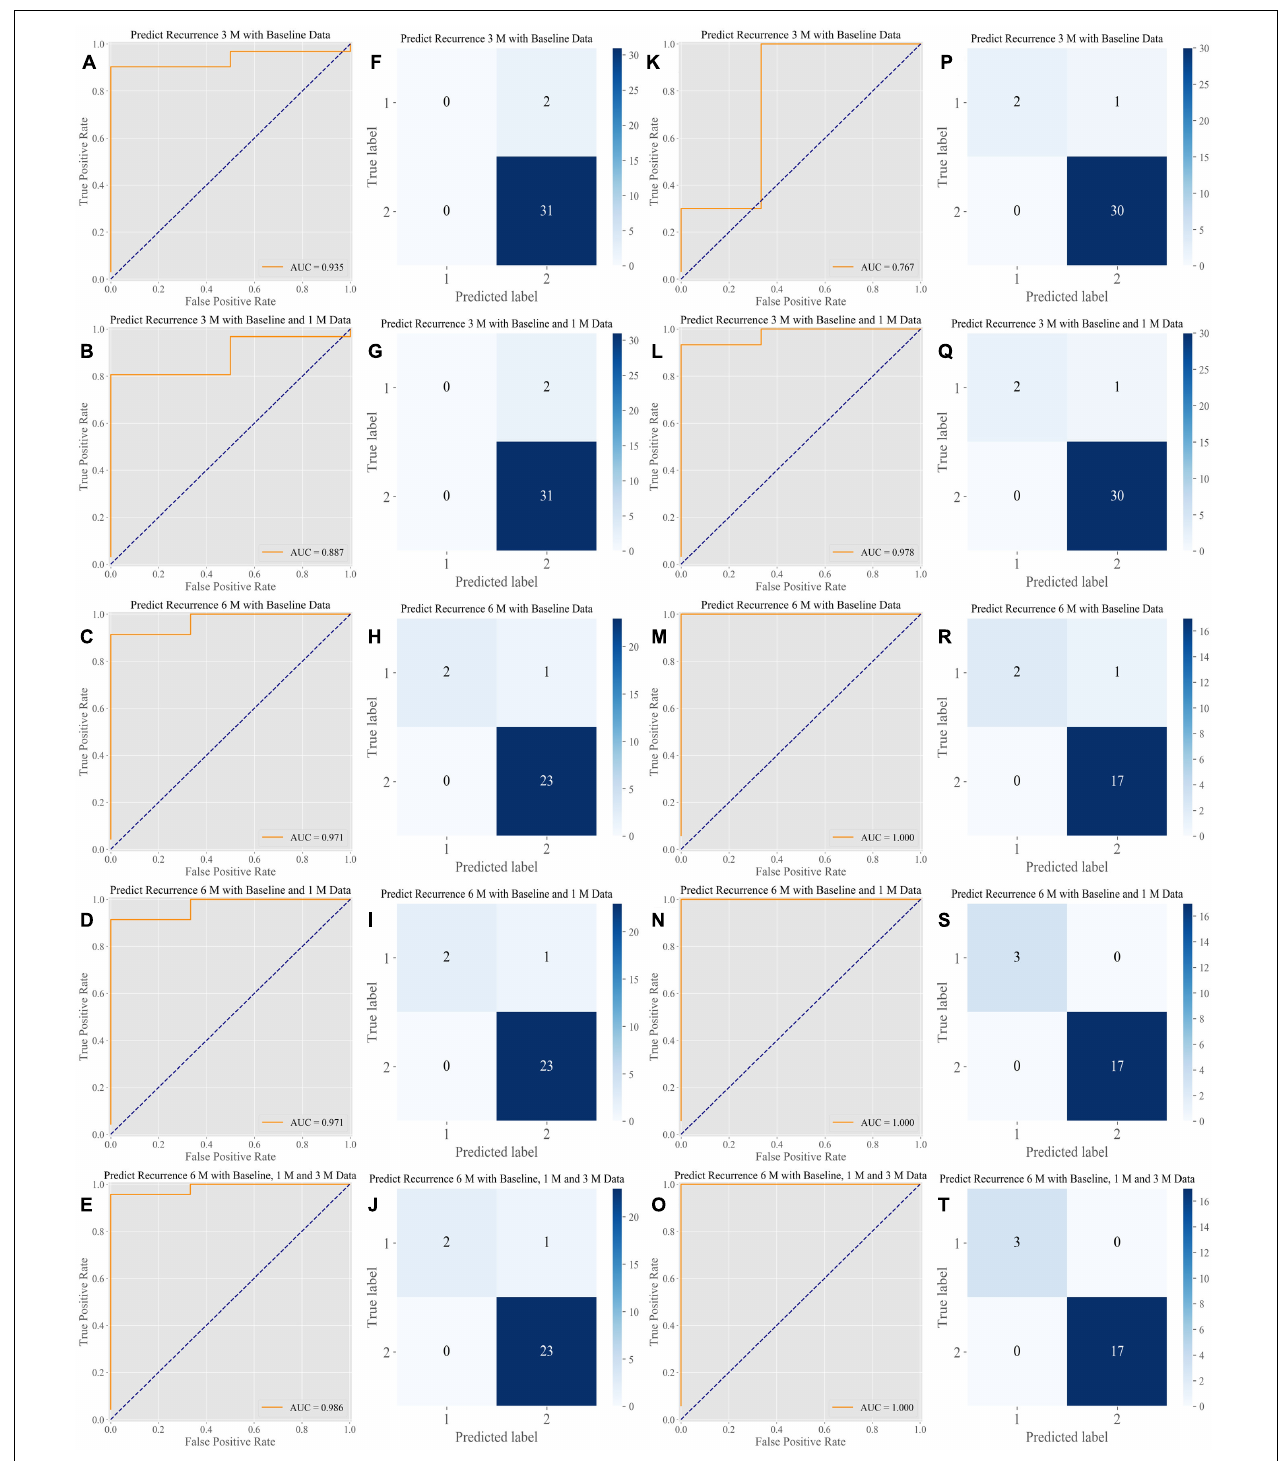
FIGURE 3 | Performance of the algorithms in the internal test dataset and the External Test Dataset of the Simplified Prediction Model. The simplified prediction model shows a comparable level of predictive power. (A–E) ROC analysis of the performance of the algorithms in the primary validation dataset. The AUCs ranged from 0.887 to 0.986 for predictions at 3 and 6 months, respectively. (F–J) CM of the classification performed by the algorithms in the primary validation dataset. (K–O) ROC analysis of the performance of the algorithms in the external testing dataset. The AUCs ranged from 0.767 to 1.000 for predictions at 3 and 6 months, respectively. (P–T) CM of the classification performed by the algorithms in the external testing dataset. ROC, receiver operating characteristic curve; AUC, area under the curve; CM, confusion matrix.